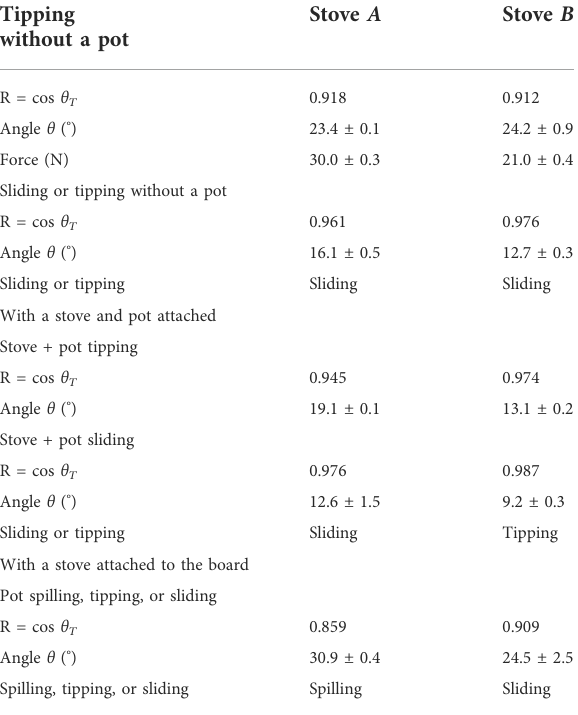
TABLE 5 Results of tipping, sliding, and spilling tests on two Chinese stoves in various con fi gurations with or without a pot in place. Tipping without a pot